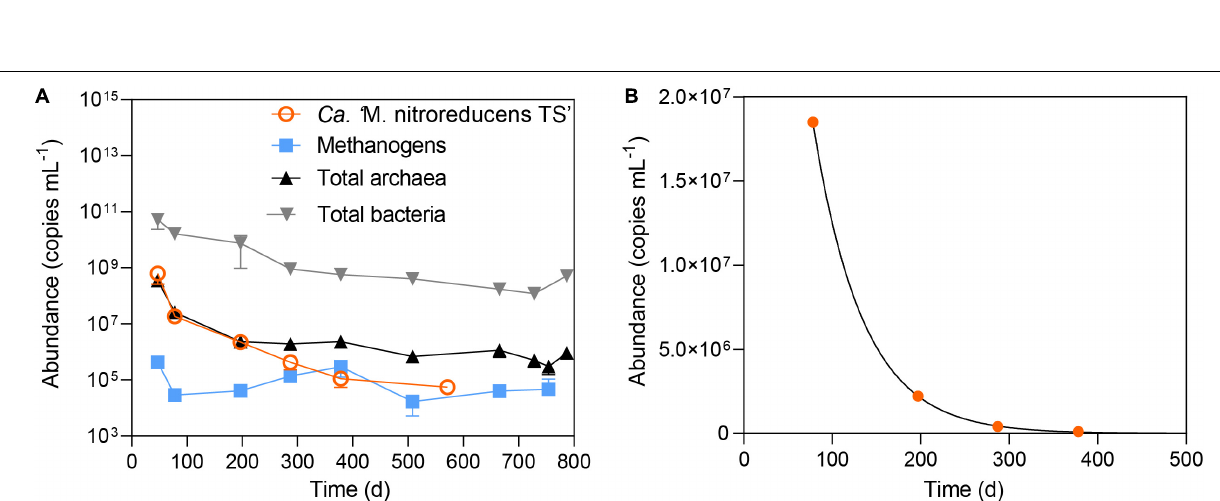
FIGURE 3 | Heatmap showing the changes in the microbial community throughout the incubation period. The legend indicates the relative abundance.